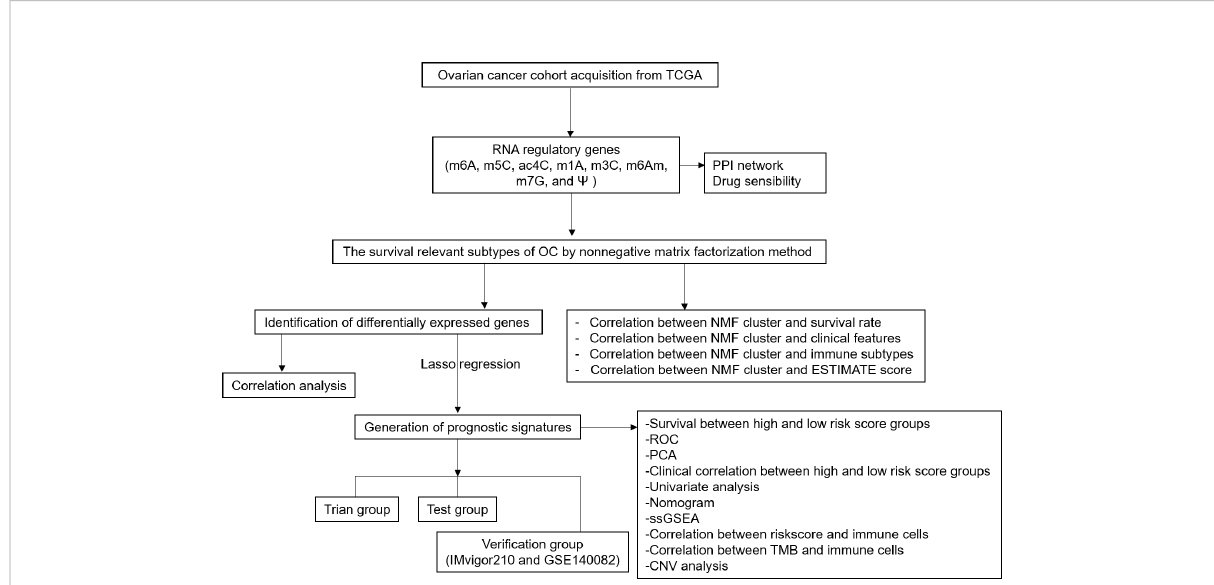
FIGURE 1 Flow chart for identi fi cation of RNA modi fi cation regulatory gene signature in ovarian